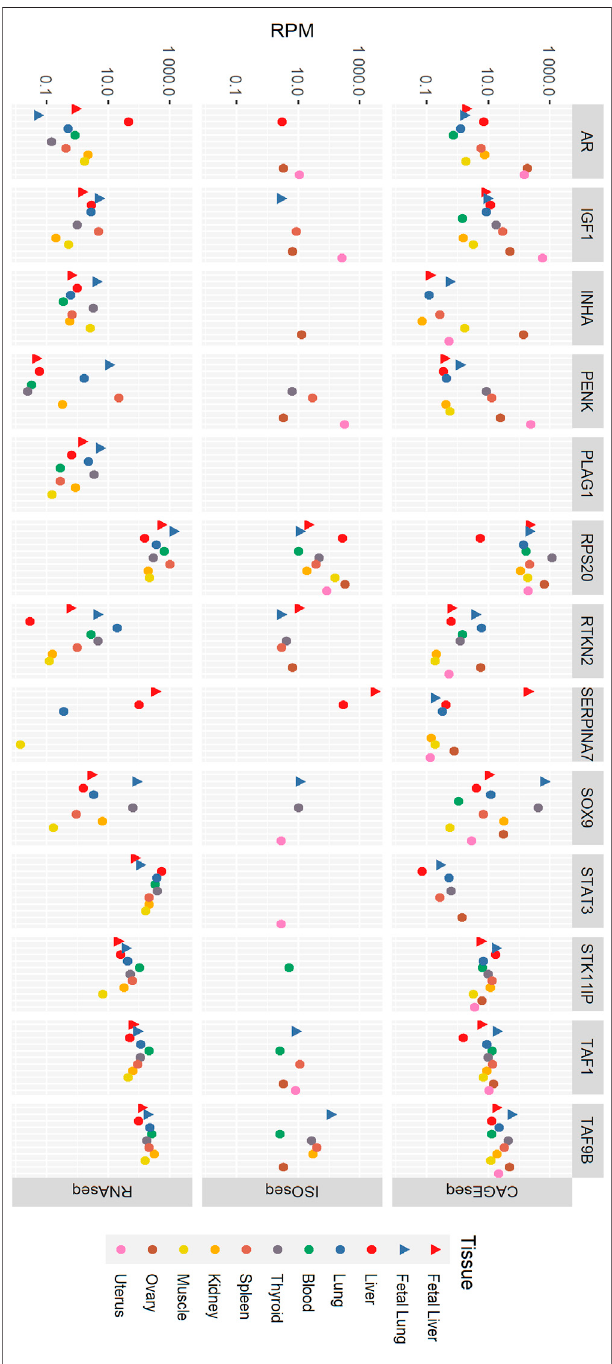
FIGURE 1 | Tissue-speci fi c expression of genes in RNA-seq, ISO-seq, and CAGE-seq data. RPM, reads per million.